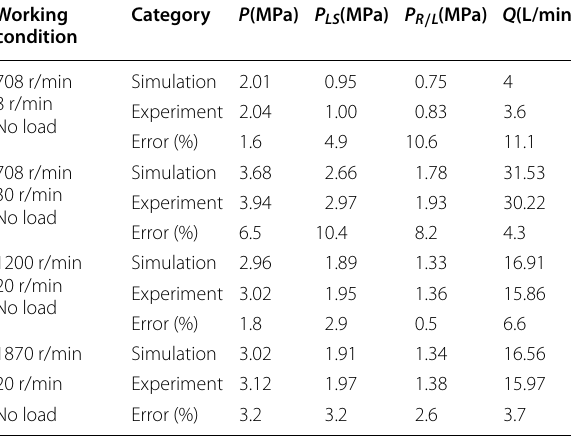
Table 3 Part of the simulation and experimental results Working condition